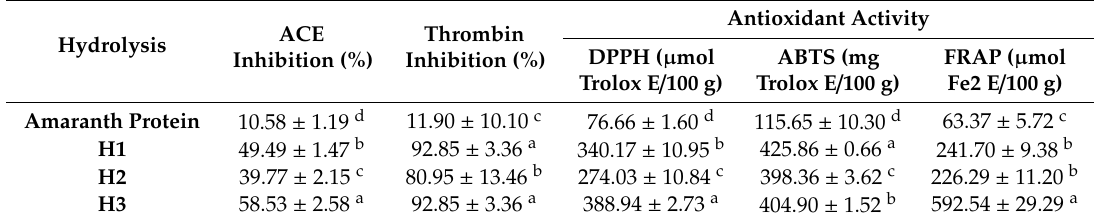
Table 1. Bioactivity potential of amaranth protein hydrolysates after treatment with alcalase (H1), flavourzyme (H2), and in two-step combined hydrolysis (H3).